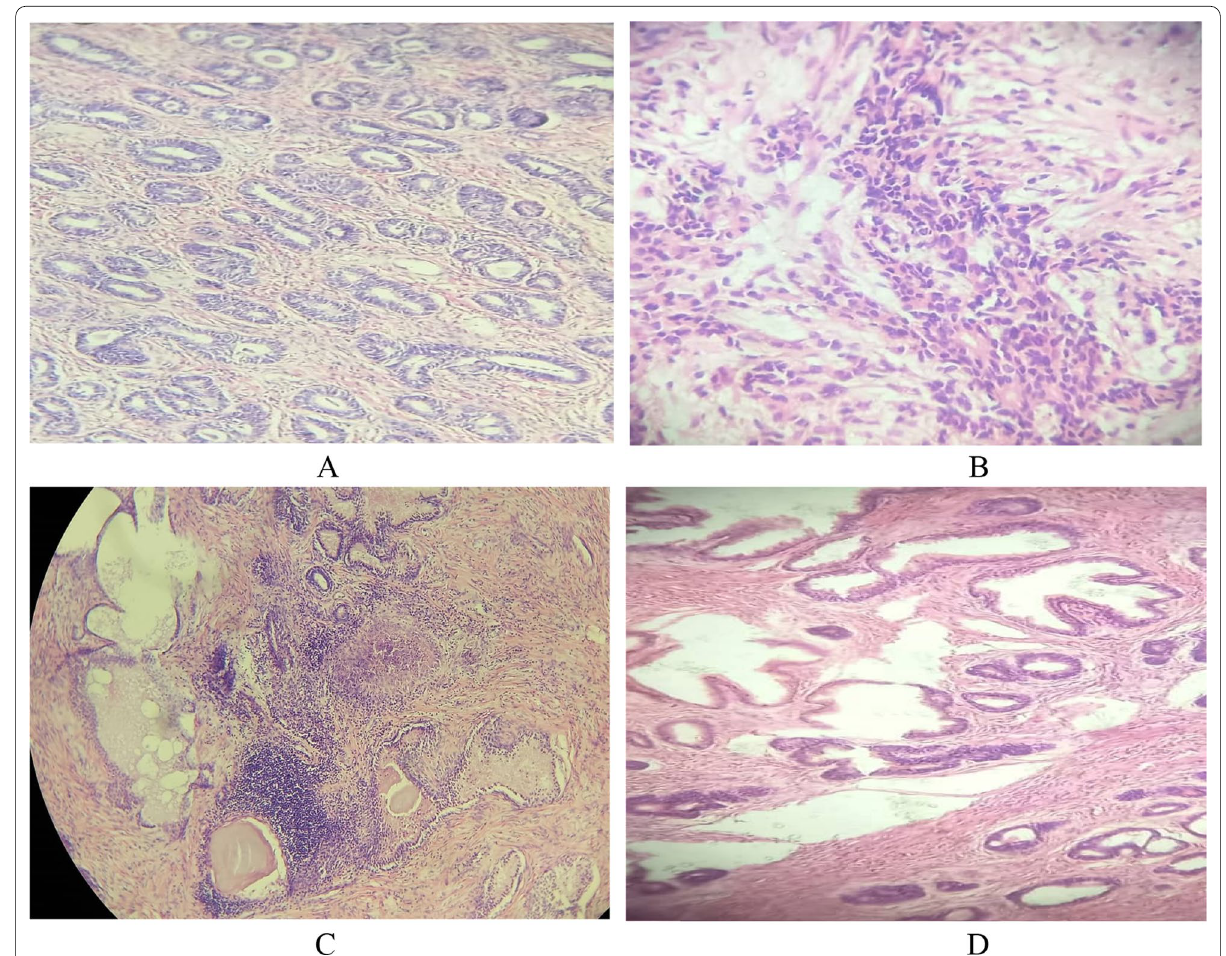
Fig. 2 The histology of the prostate in the control and prostate cancer groups. A Normal prostate, B Prostate cancer, C Prostatitis, D Benign prostatic hyperplasia(Mag ×